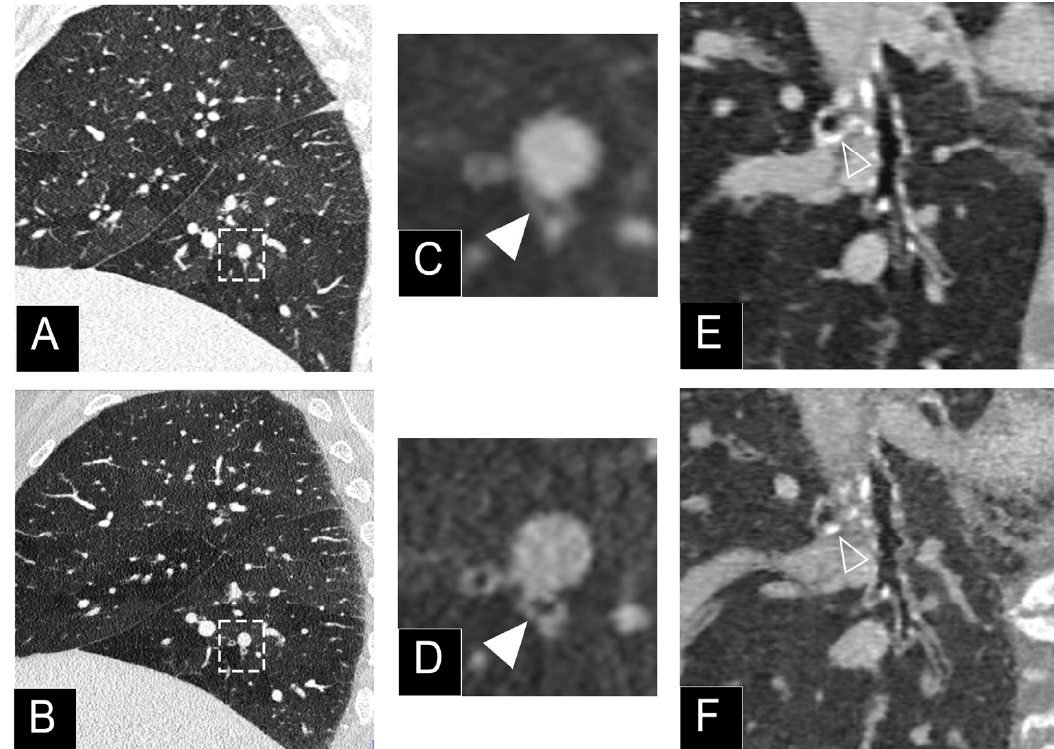
Figure 9. Comparison of the airways imaging in a 72-year-old patient with a respiratory bronchiolitis, which was on the same day as a clinical prototype PCD-CT (first row; Philips, Haifa, Israel) and a dual-layer EID-CT (second row; iQon, Philips). Sagittal views ( A , B ) demonstrated thickening of the bronchial wall as well as a mosaicism probably due to air trapping. Close-up views of the airspaces ( C , D ) showed a better sharpness and conspicuity of the bronchial wall (white arrowheads) with PCD-CT ( D ). Greater sharpness of the bronchial calcifications were noticed on PCD-CT images ( F ) compared to EID-CT images (( E ); white empty arrowheads).